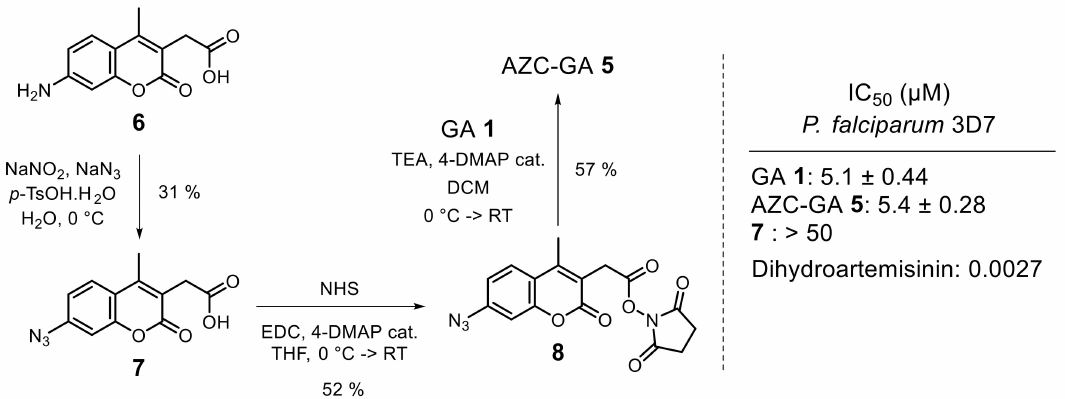
Figure 3. Synthesis and in vitro antiplasmodial activity of AZC-GA 2